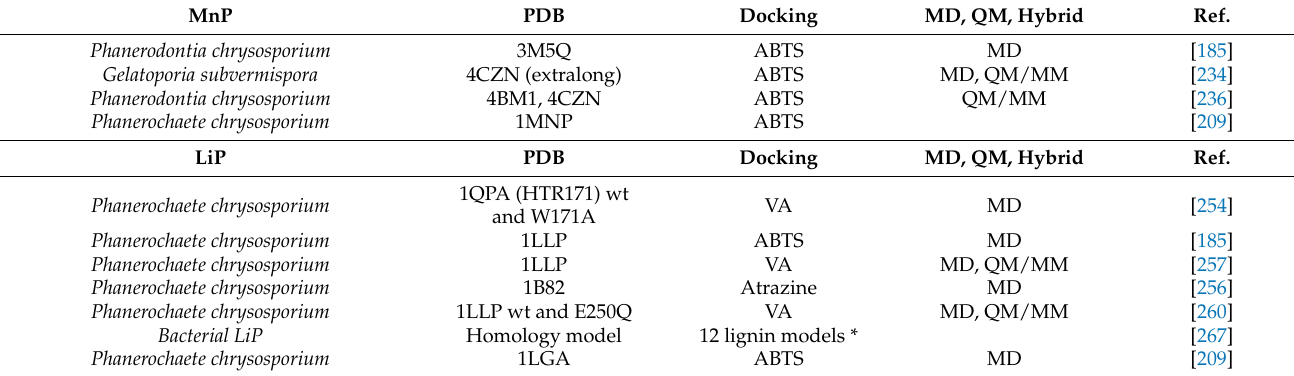
Table 4. Summary of the literature about molecular docking, MD, QM, or hybrid studies on MnP and LiP interaction with ligninolytic substrates or ABTS. PDB Docking MD, QM, Hybrid